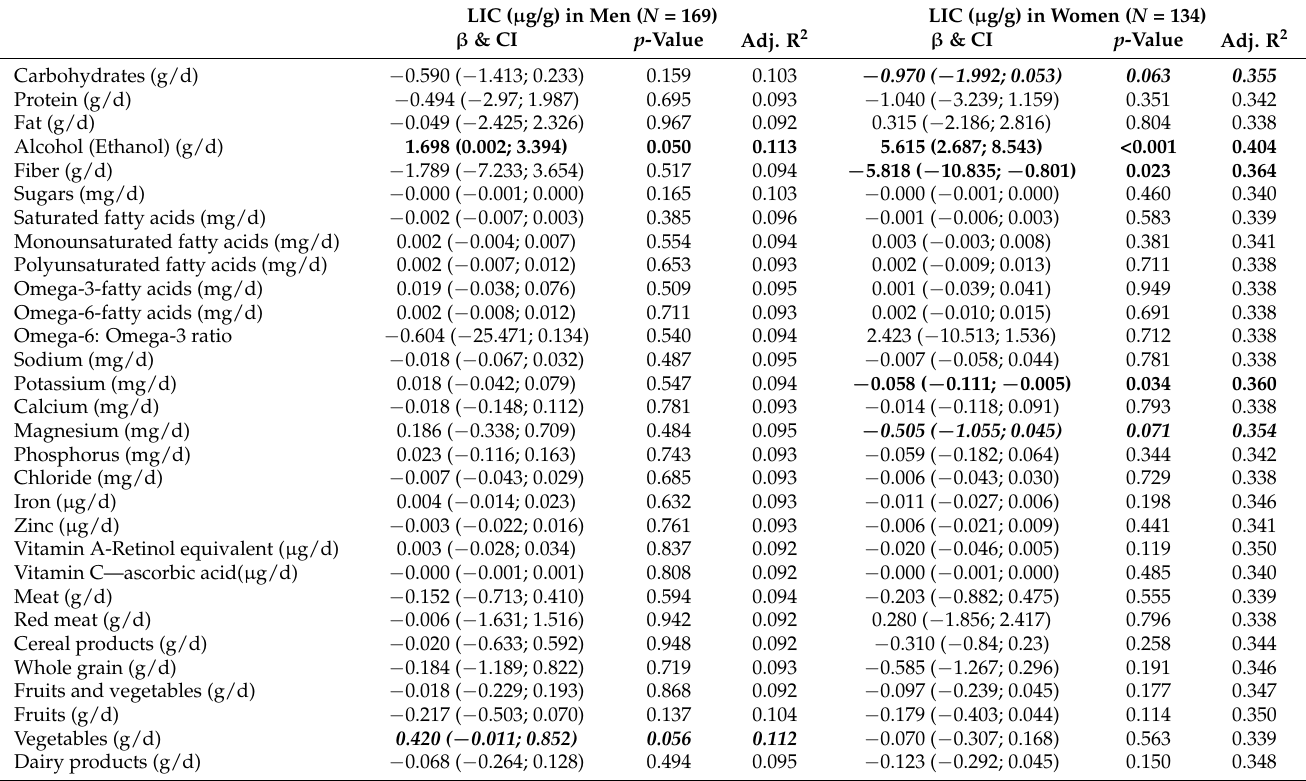
Table 3. Association of food and nutrient intake with LIC in men and